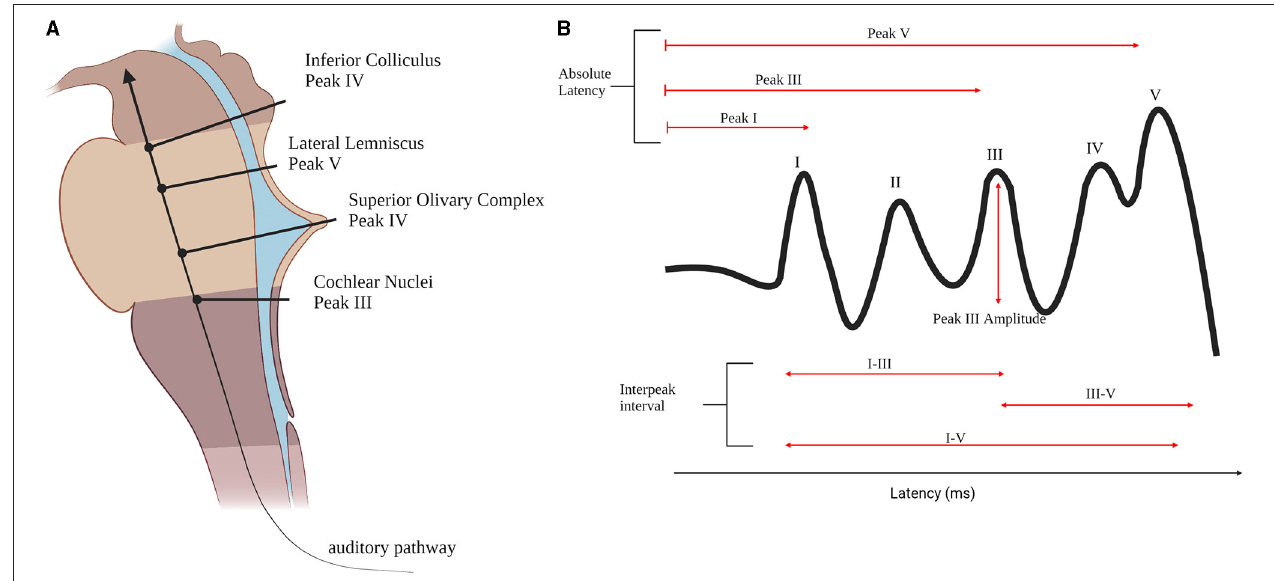
FIGURE 2 | Brainstem auditory pathway. (A) The brainstem auditory pathway and the corresponding ABR peaks generators in the brainstem. (B) An ABR wave and the measures found to be different between autistic individuals and controls. Created with bioRender.com.